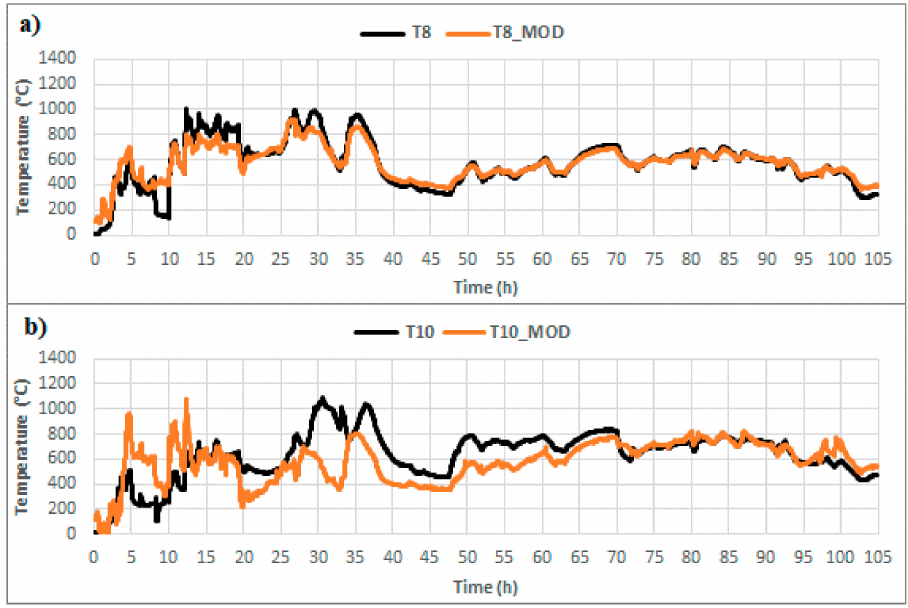
Figure 13. The measured (T) and modeled (T_MOD) temperature behavior, ( a ) temperature T 8 , ( b ) temperature T 10 (Source: own elaboration).